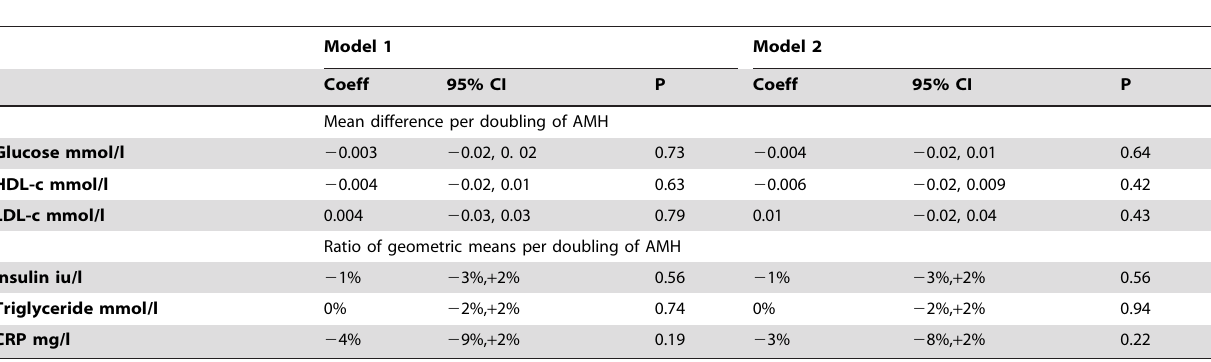
Table 3. Multivariable associations of AMH with cardiometabolic risk factors (n=1,308).